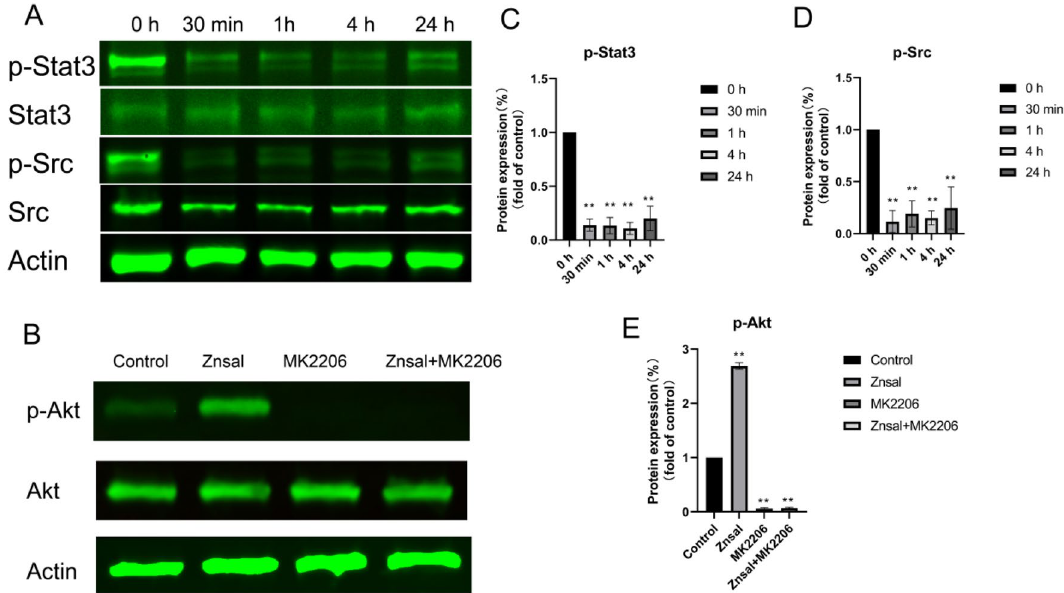
Figure 4. Zn{[CH 3 ) 3 C] 2 Sal} 2 2− inhibits the activation of the STAT3 signaling pathway and SRC pathway. ( A ) The protein expression levels of STAT3, p-STAT3, p-Src, and Src at different time points in 4T1 cells treated with Zn{[CH 3 ) 3 C] 2 Sal} 2 2− were analyzed by western blot. ( B ) The protein expression levels of Akt and p-Akt were analyzed by western blot after 30 min of treatment with Zn{[CH 3 ) 3 C] 2 Sal} 2 2− or MK2206 alone or in combination. ( C – E ) Expression changes (fold change relative to control) of p-STAT3, p-Src and p-Akt 473 were analyzed by densitometry with the results of two independent Western blots. Data are presented as the mean ± SEM (* P < 0.05, ** P <